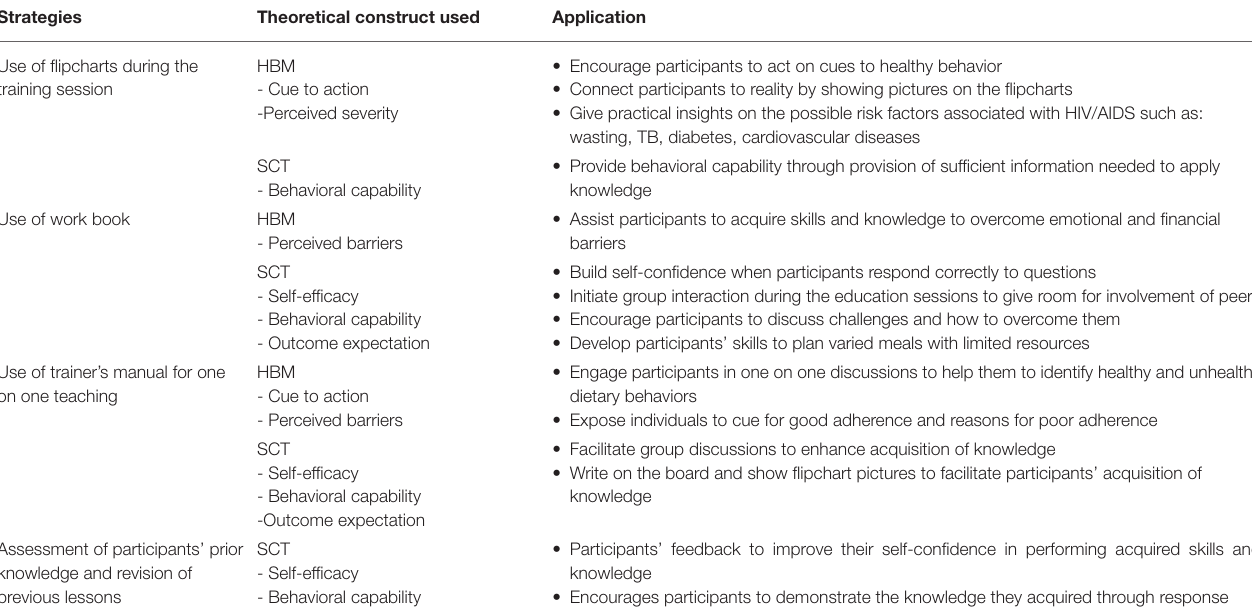
TABLE 3 | Theory-based strategies and practical applications in educational activities.